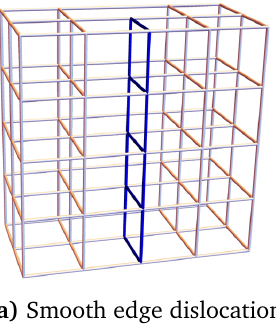
Figure 20: The lattice with edge dislocations as a half-plane added to a simple cubic lattice. The extra half-plane is